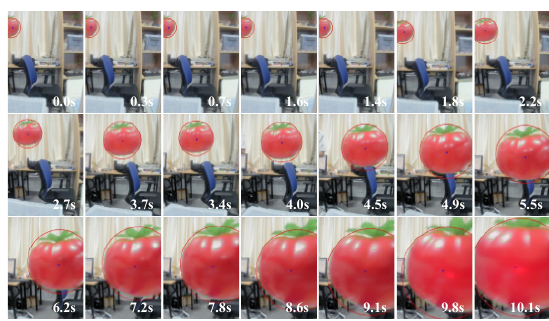
Figure 23. Camera taking images when the manipulator approached the target.